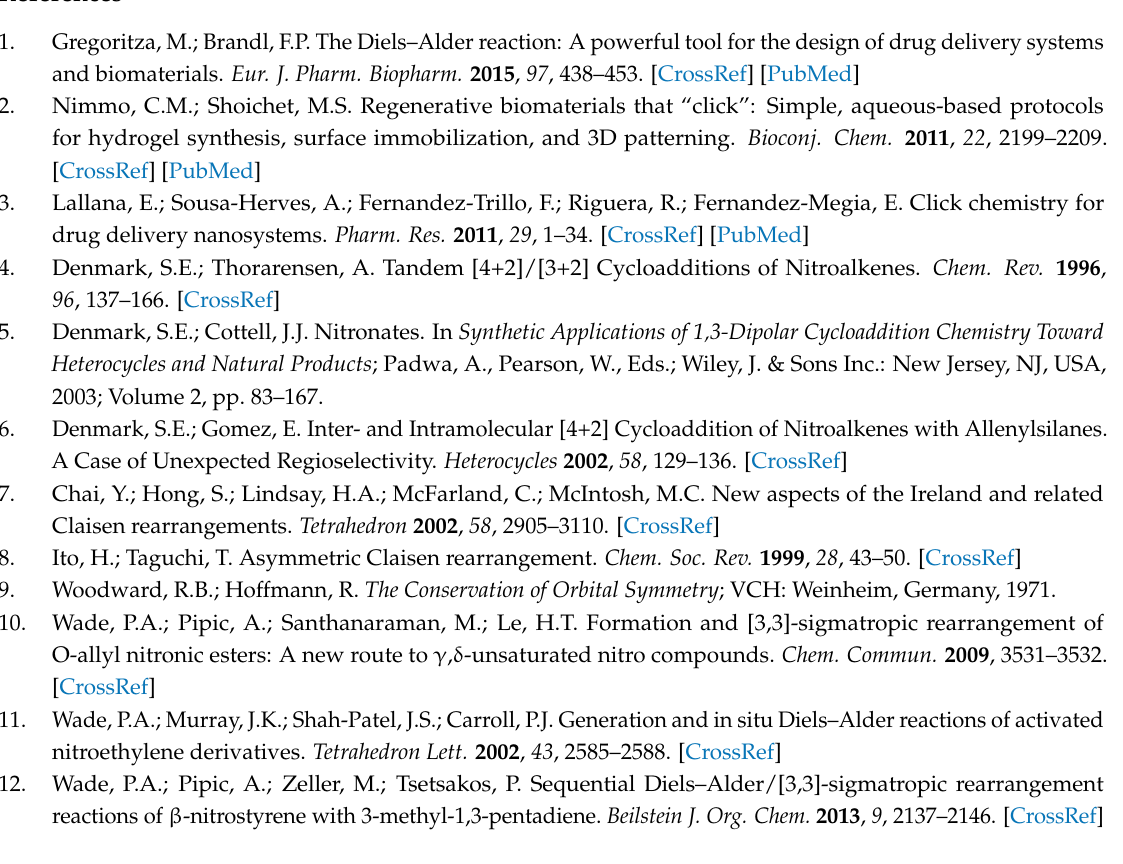
Supplementary Materials: Table S1: B3LYP thermodynamic parameters and relative energies for the rearrangement of internal nitronic ester 1 to nitronorbornene 2; Table S2: M06-2X thermodynamic parameters and relative energies for the rearrangement of internal nitronic ester 1 to nitronorbornene 2; Table S3: B3LYP/6-31G(d) thermodynamic parameters and relative energies for the rearrangement of internal nitronic ester 1 to nitronorbornene 2 in simulated presence of polar reaction medium; Table S4: B3LYP/6-31G(d) key parameters for the stationary points involved in the rearrangement of 1 into 2 in different reaction medium; Table S5: Cartesian coordinates from the B3LYP/6-31G(d) calculations for the structures of rearrangement of internal nitronic ester 1 to nitronorbornene 2. Funding: This research was funded by Polish State Committee, grant number C-2/493/2018/DS-M and this research was supported in part by PL-Grid